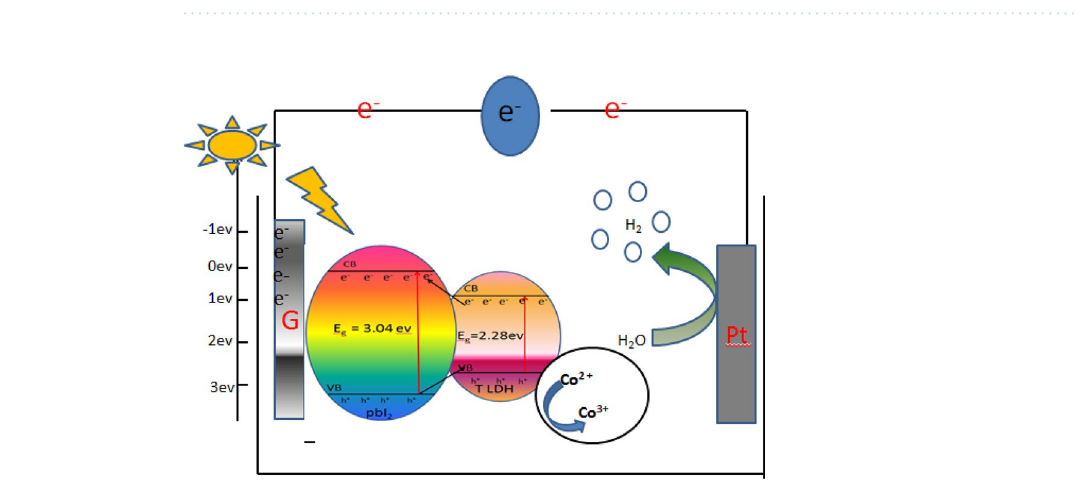
Table 2. Comparison of the PEC performance parameters of the present work with the previously reported data for LDH-based PEC catalysts.